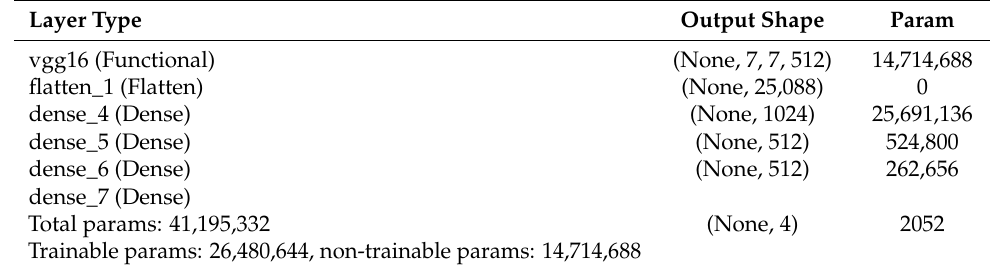
Table 4. VGG16 Transfer Learning summary.